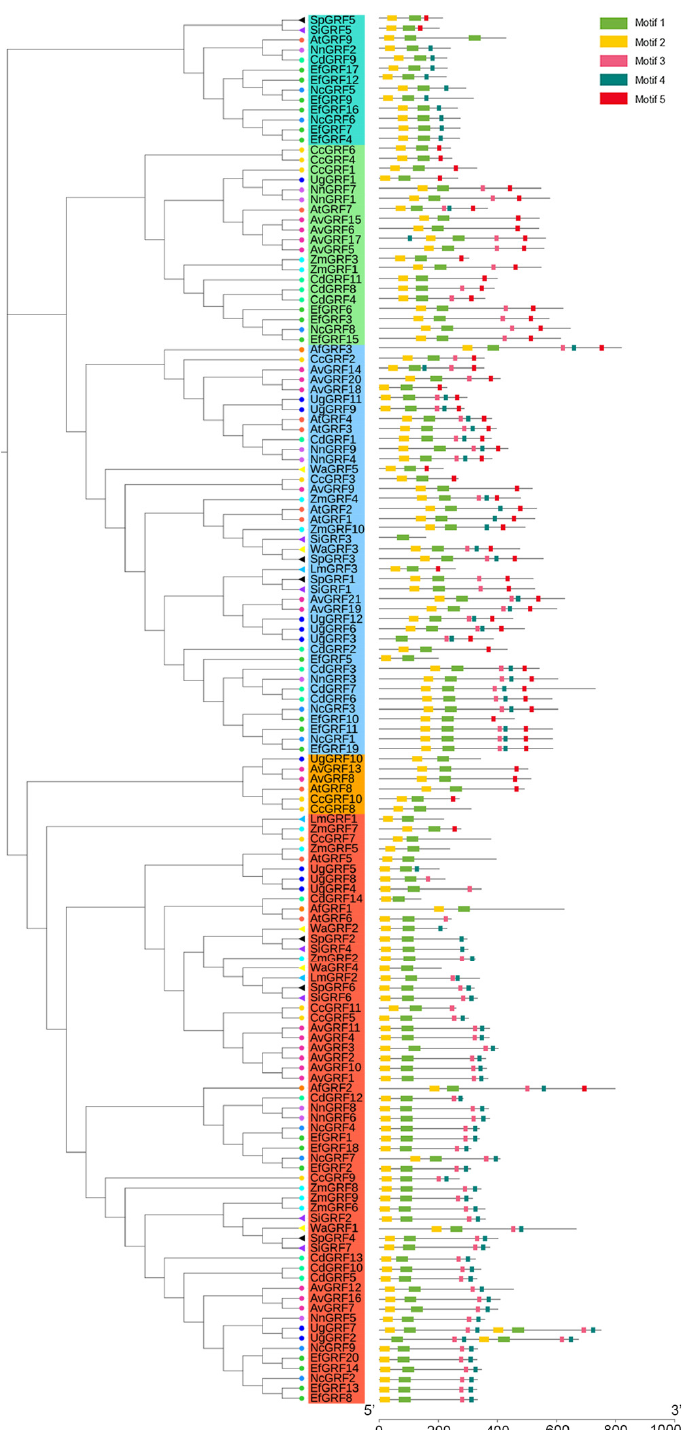
Figure 4. Conserved motifs of the GRFs . The GRFs from different species were labeled with different colored symbols. Tomato circles indicate genes from A. thaliana ; Dark orange circles indicate genes from A. filiculoides ; Maroon circles indicate genes from A. vesiculosa ; Gold circles indicate genes from C. chinensis ; Yellow circles indicate genes from C. demersum ; Dark gold circles indicate genes from E. ferox ; Blue circles indicate genes from U. gibba ; Dodger blue circles indicate genes from N. col- orata ; Medium orchid circles indicate genes from N. nucifera ; Cyan circles indicate genes from Z. marina ; Deep sky blue triangles indicate genes from L. minuta ; Purple triangles indicate genes from S. intermedia ; Black triangles indicate genes from S. polyrhiza ; Yellow triangles indicate genes from W. australiana